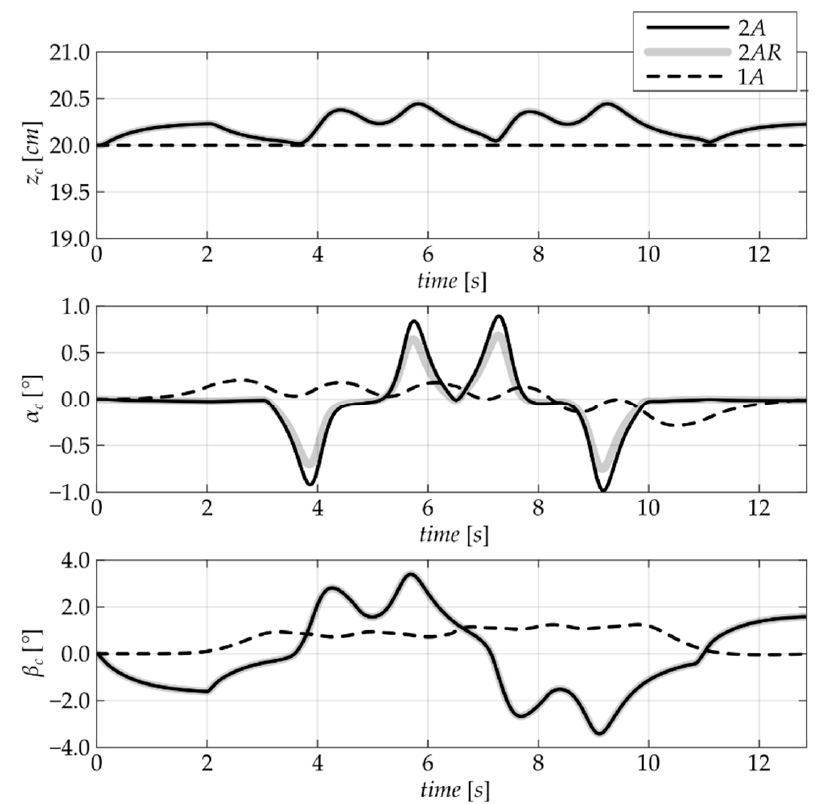
Figure 9. Use case simulation 1: non-controlled degrees of freedom.